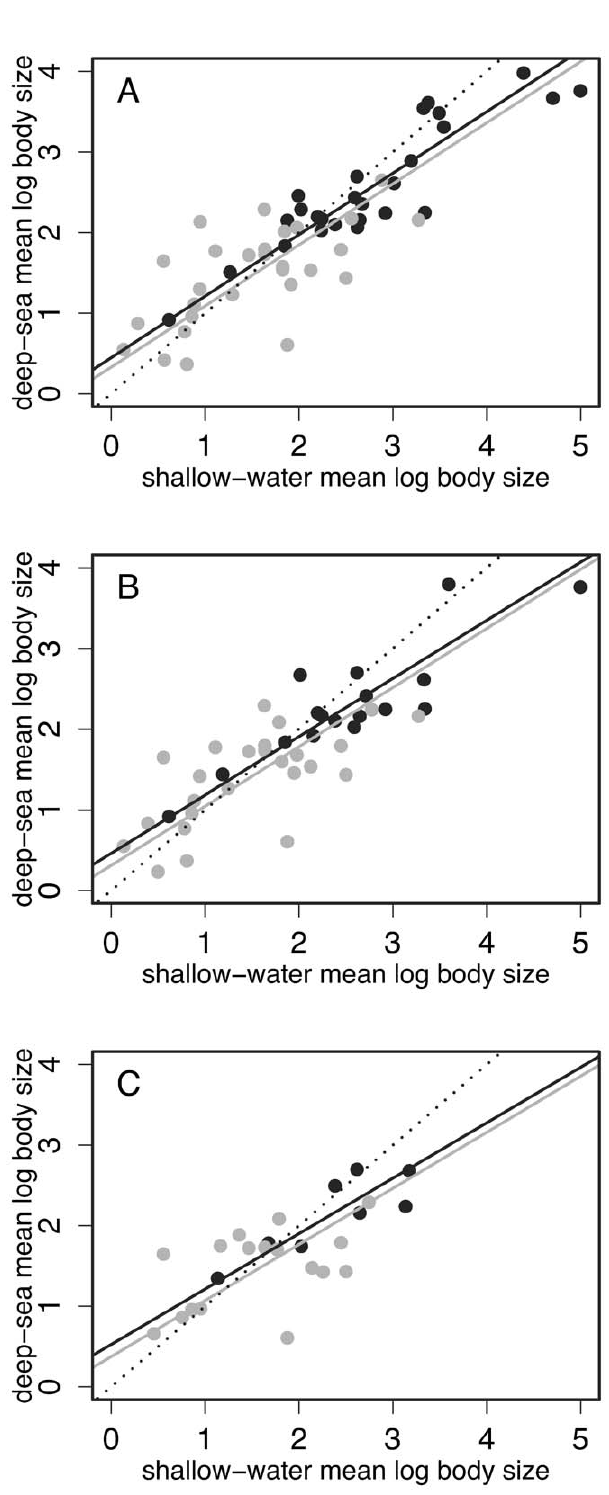
Figure 2. Comparison of effect size across depths and taxonomic groups. The body sizes of deep-sea gastropods are plotted against those of their shallow-water congeners. ‘‘Shallow- water’’ species were never observed below 200m, and ‘‘deep-sea’’ species never observed above depths of A: 200m, B: 400m and C: 600m. Separate standardized-major-axis regression lines are shown for the Neogastropoda (black points) and all other groups (grey points). The dotted line is the 1:1 expected under the null. Genera with fewer than two deep and two shallow species were excluded.